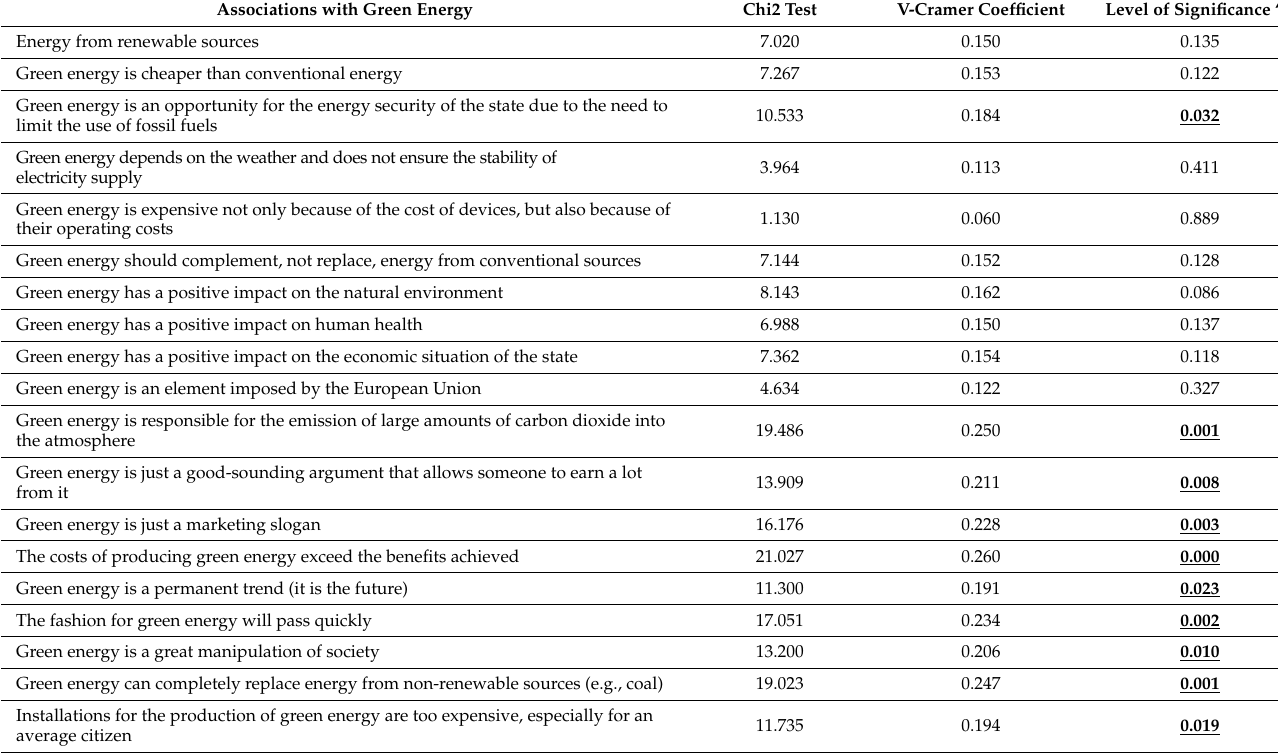
Table 4. Respondents’ associations with green energy and the subjective self-assessment of the level of knowledge about green